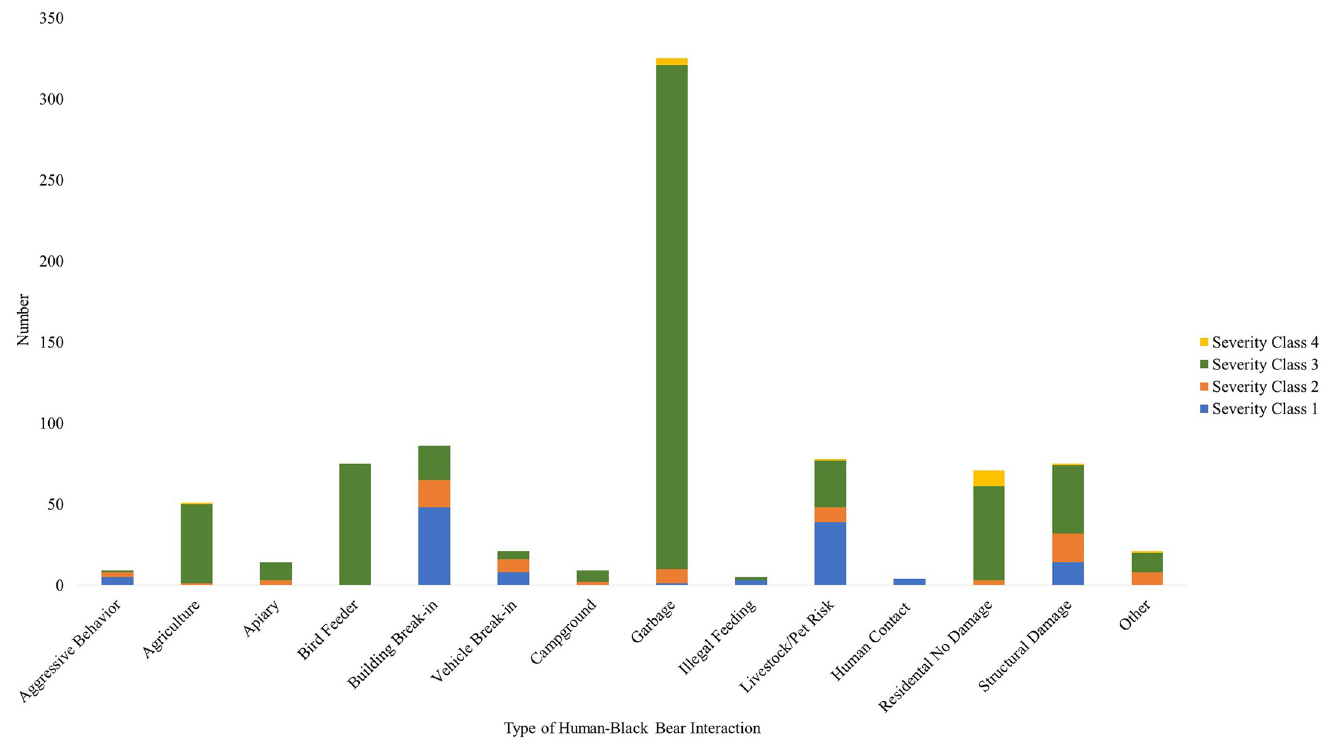
Fig 2. Catskills’ human-black bear interactions recorded by the DEC in 2018 and 2019 (n = 842). Bars are color coded by severity class; 1 (blue) is the highest severity, 4 (yellow) the lowest. https://doi.org/10.1371/journal.pone.0257716.g002 test the model. This test yielded an AUC value of 0.801, and an overall omission error of 0.291 (0.326 for conflict locations, 0.254 for non-conflict locations). Using k-fold cross validation across the state-wide dataset generated models that varied in AUC, AIC, and omission error (Table 4). All data were then recompiled, and the model produced was then projected to map human-black bear interactions in the region (AIC = 10283.4, AUC = 0.795, overall emission error = 0.234; Fig 3).